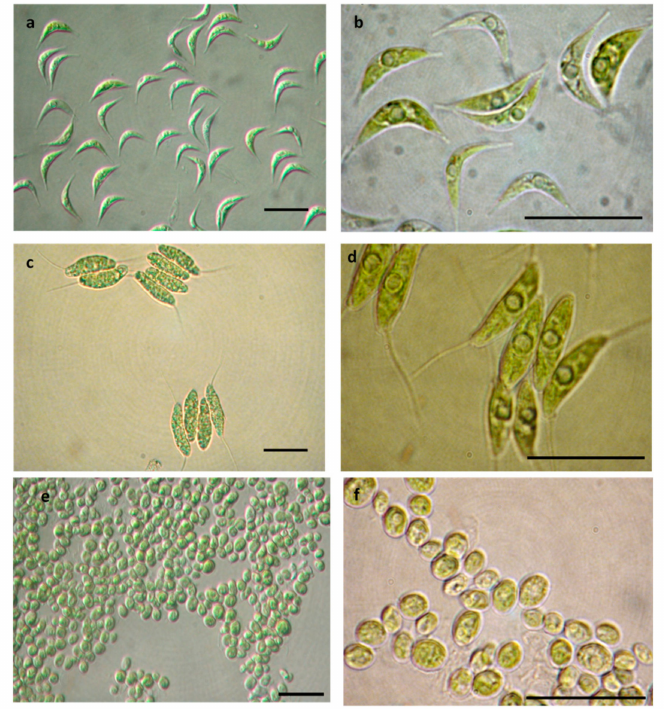
Figure 3. Light microscopy (LM) observations of S. acuminatus SAG 38.81 grown in BBM + N / L 200 ( a ) at the start and ( b ) at stationary phase; D. abundans ACUF 283 / 1.8 in BBM + N / L 200 ( c ) at the start and ( d ) at stationary phase; D. opoliensis SAG 64.94 in BBM-N / L 120 ( e ) at the start and ( f ) at stationary phase. bar = 10 µ